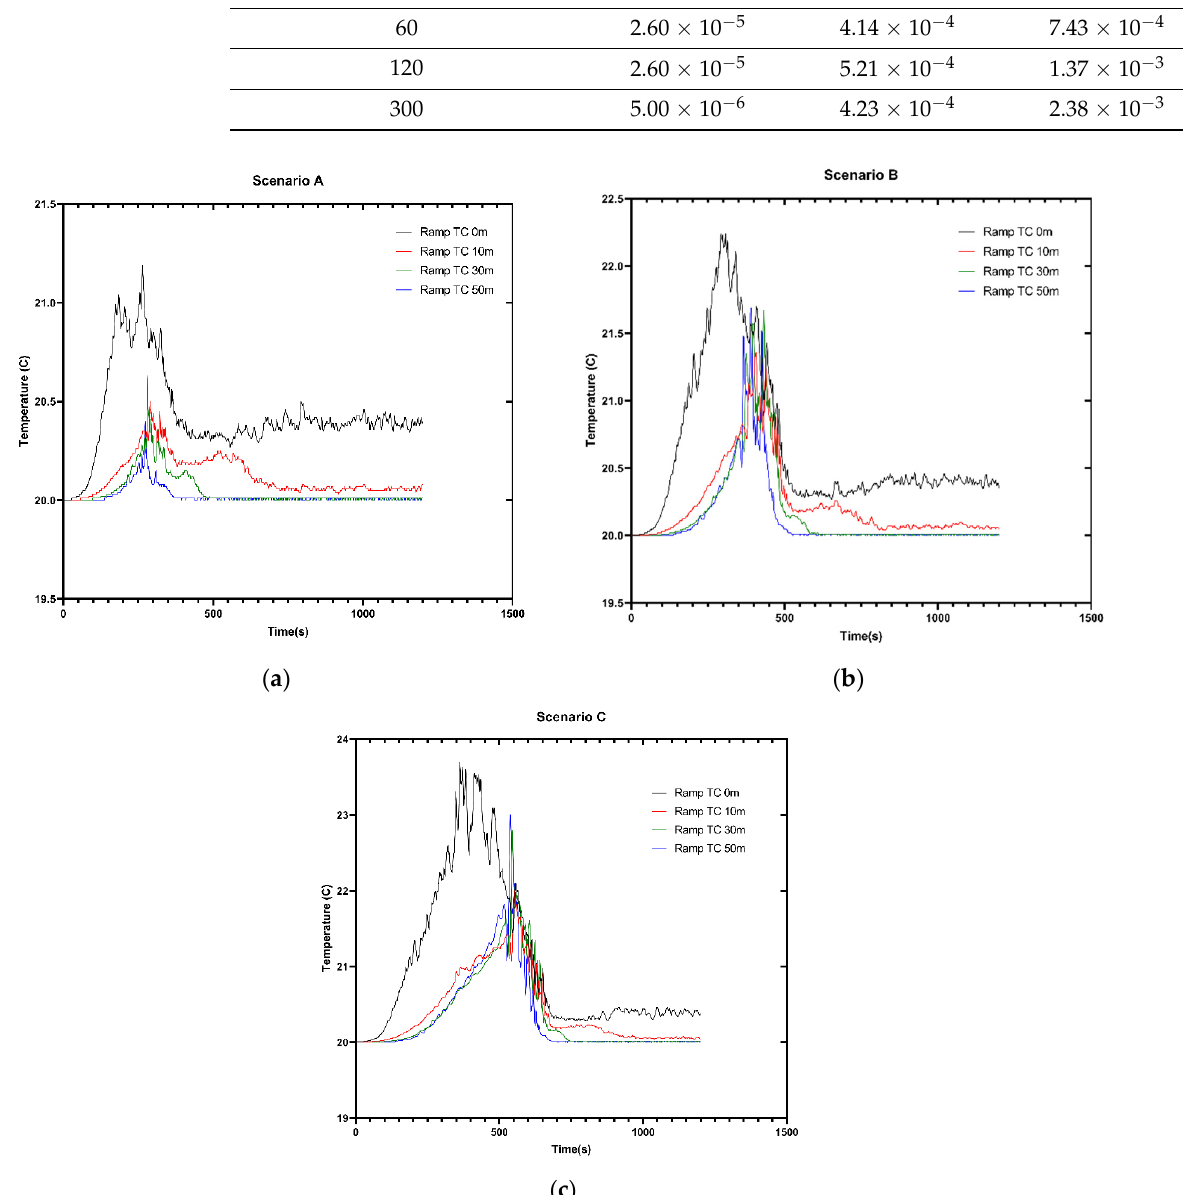
Figure 14. Temperature distribution upwind from the fire source at y = 0.5 m (middle of the walking platform) and at a height of 2 m for ( a ) Scenario A, ( b ) Scenario B, and ( c ) Scenario C. Temperatures do not exceed 24 ℃.